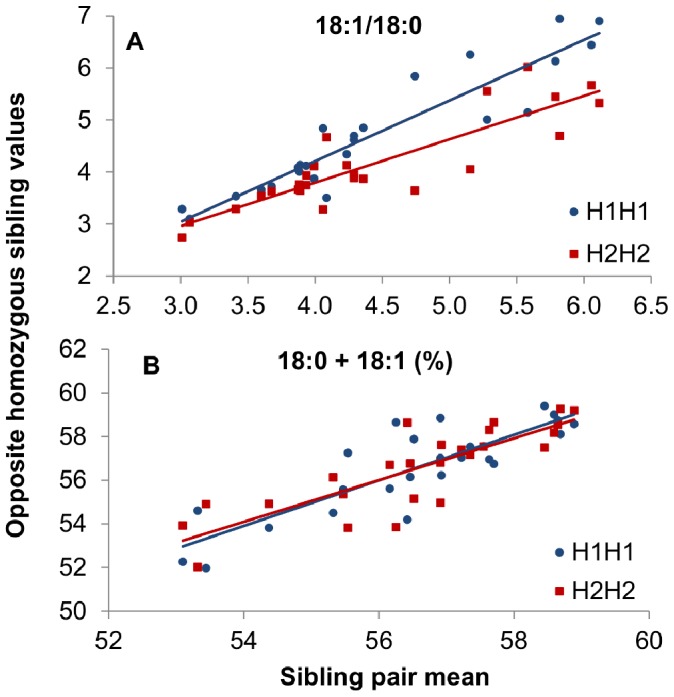
Desaturation ratio in opposite homozygous siblings for SCD haplotypes H1 and H2.(A) Ratio 18∶1/18∶0, and (B) 18∶0+18∶1 content (in percentage of total fatty acids) in the muscle gluteus medius of homozygous H1H1 and H2H2 sibling pairs (n = 25) are plotted against the sibling pair mean value. The H1H1 pigs showed a greater desaturation ratio (p<0.01) than their H2H2 sibs but the same 18∶0+18∶1 (p = 0.94) content. The associated p-values were determined using a paired t-test. Regression lines were fitted for each diplotype (blue: H1H1; red: H2H2). The difference between homozygotes for 18∶1/18∶0 increased with 18∶1/18∶0 (p<0.05), with H1H1 sibs showing a trend higher than the expected (1.17±0.10) and H2H2 sibs lower (0.83±0.10). The regression of 18∶0+18∶1 on the litter mean value was not different from the average trend (unity) in both genotypes (p = 0.89).